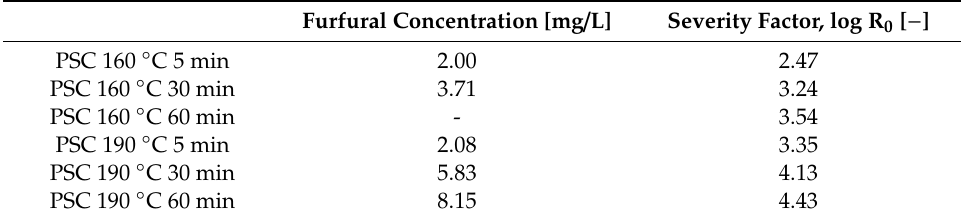
Table 3. Furfural concentrations of pretreated cattle manure and severity